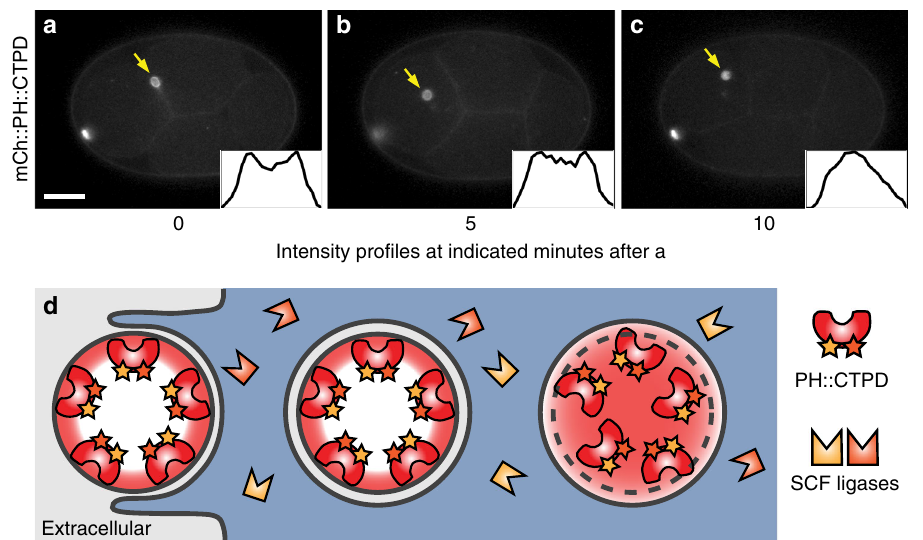
Fig. 6 Degron reporters label speci fi c membranes. a The mCh::PH::CTPD reporter brightly labels the plasma membrane of the polar bodies and weakly labels the plasma membrane of embryonic cells at the four-cell stage ( n = 22). Scale bar: 10 µ m. b After phagocytosis of the second polar body (2PB, arrow), the plasma membrane of the 2PB is distinctly visible. c Several minutes later, the corpse plasma membrane breaks down inside the phagolysosome and the mCh::PH::CTPD reporter disperses throughout the phagolysosome lumen, as demonstrated by line scans through the phagolysosome (insets). See also Supplementary Movie 2. d The mCh::PH::CTPD reporters inside the corpse membrane are protected from degradation before and after phagocytosis. Model of membrane breakdown inside the phagolysosome, demonstrating the shape change from a hollow to a fi lled sphere NATURE COMMUNICATIONS| (2019) 10:3490